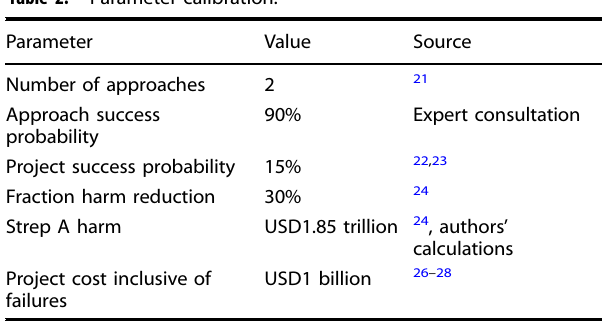
Table 2. Parameter calibration.